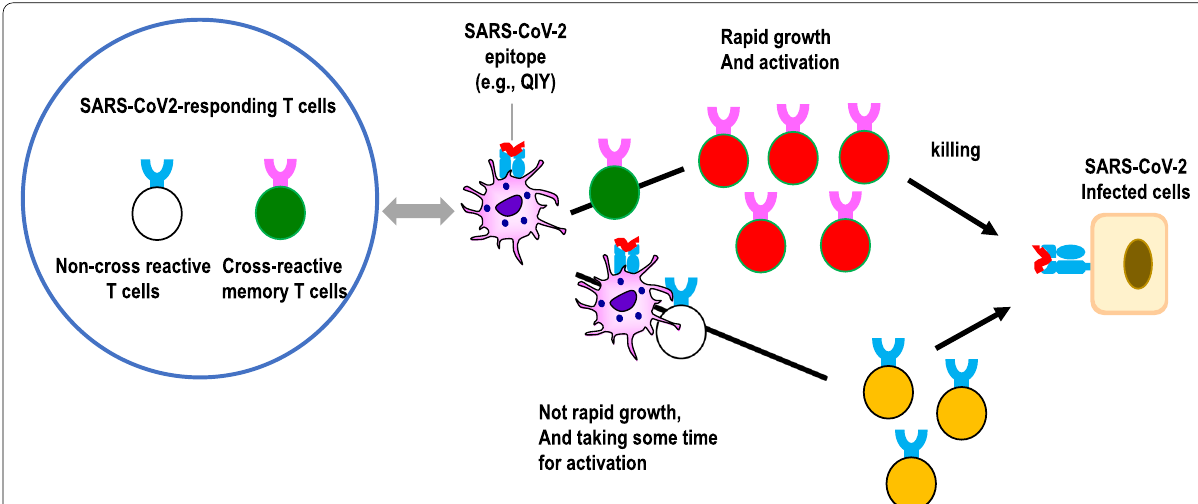
Fig. 2 Different roles of specific and cross‑reactive T cells in the immune response to SARS‑CoV‑2 infection. When an optimal epitope with high activation potential is identified, cross‑reactive T cells proliferate rapidly and robustly in a short period of time, resulting in a strong anti‑viral response. In case of specific, non‑cross‑reactive T cells against SARS‑CoV‑2, T cell activation requires dendritic cells for priming, which takes time (approximately 1–2 weeks for activation and over a month for memory T cell